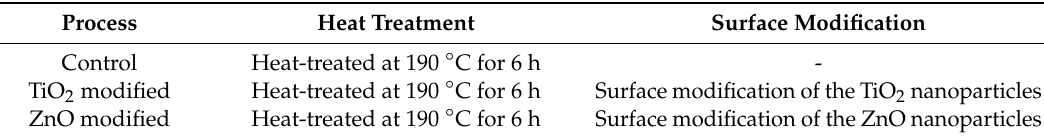
Table 1. The process of the surface-modified